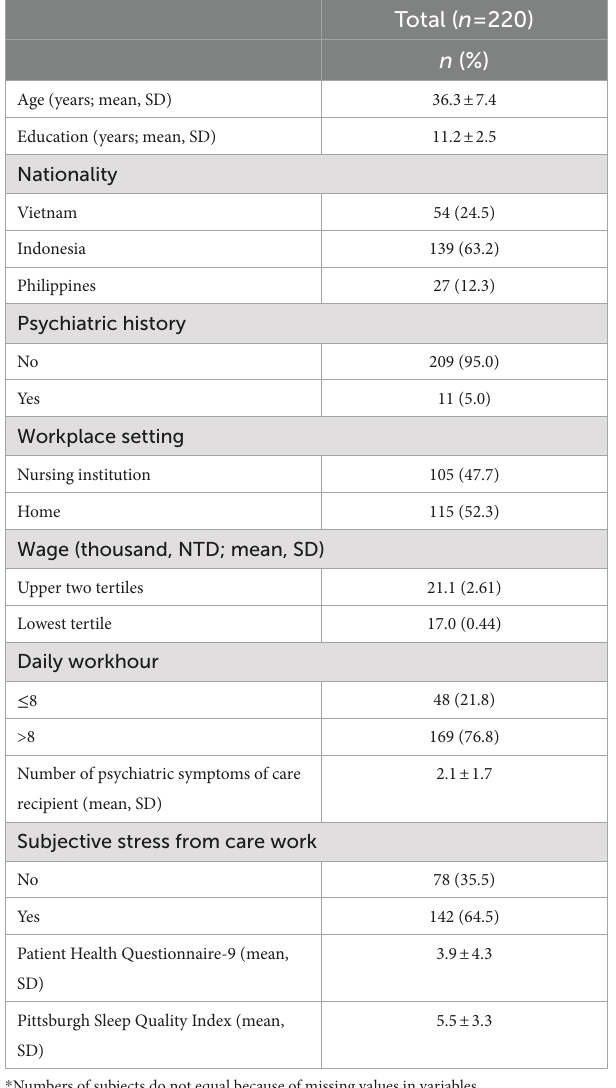
TABLE 1 Sociodemographic and clinical characteristics of participants ( n = 220).